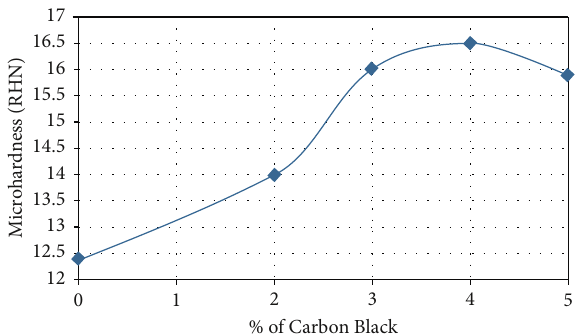
Figure 4: Effect of carbon black on microhardness of the vinyl ester composites.